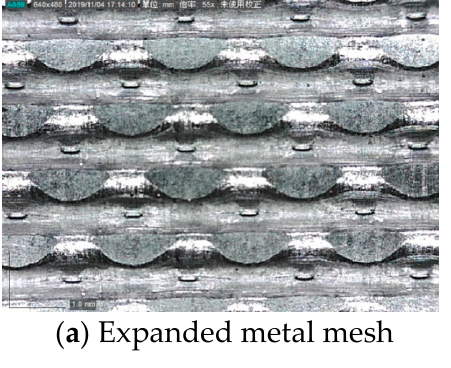
Figure 1. Materials. Table 1. Detailed thickness of stage 1